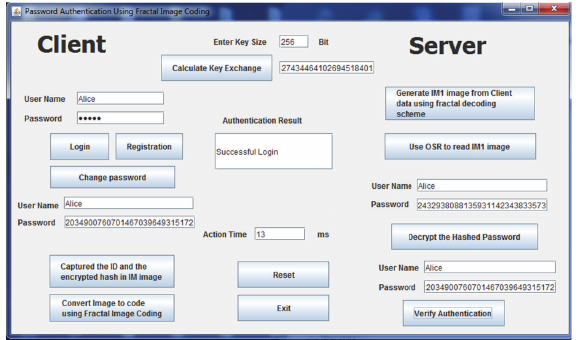
Figure 2: User Interface for password authentication using fractal image coding software.